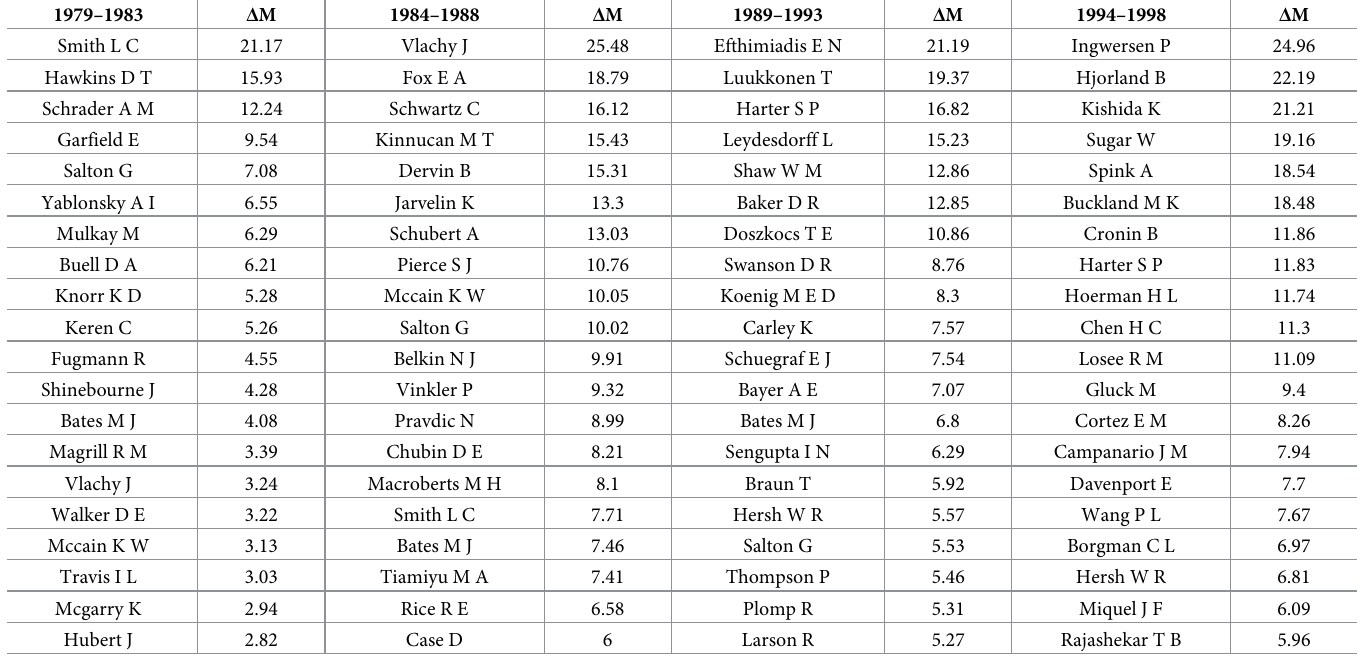
Table 1. Top 20 researchers with the largest Δ M in each of the 5-year time intervals (1979–1998).